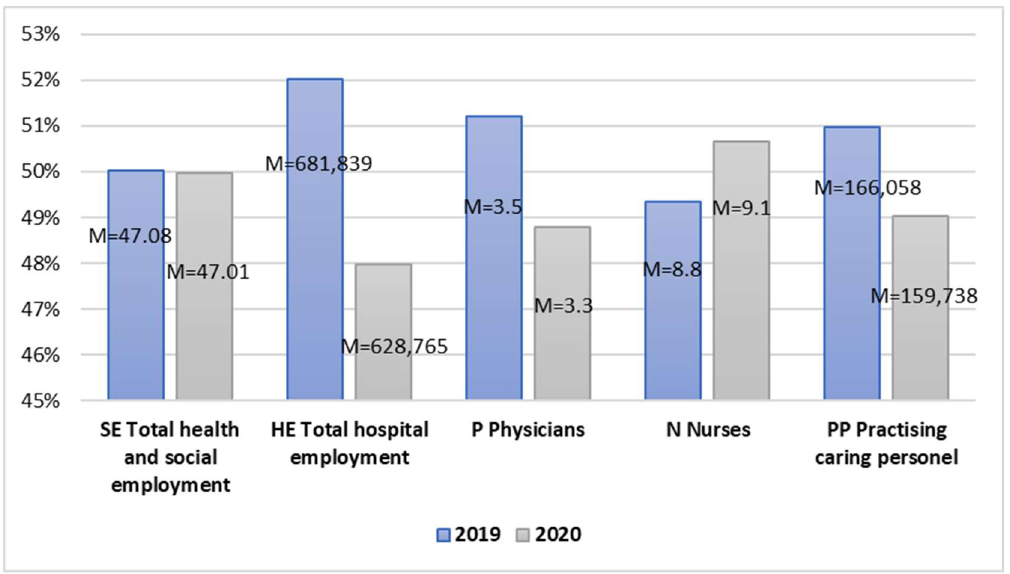
Figure 3. Independent sample mean values in the area of human resources in healthcare.